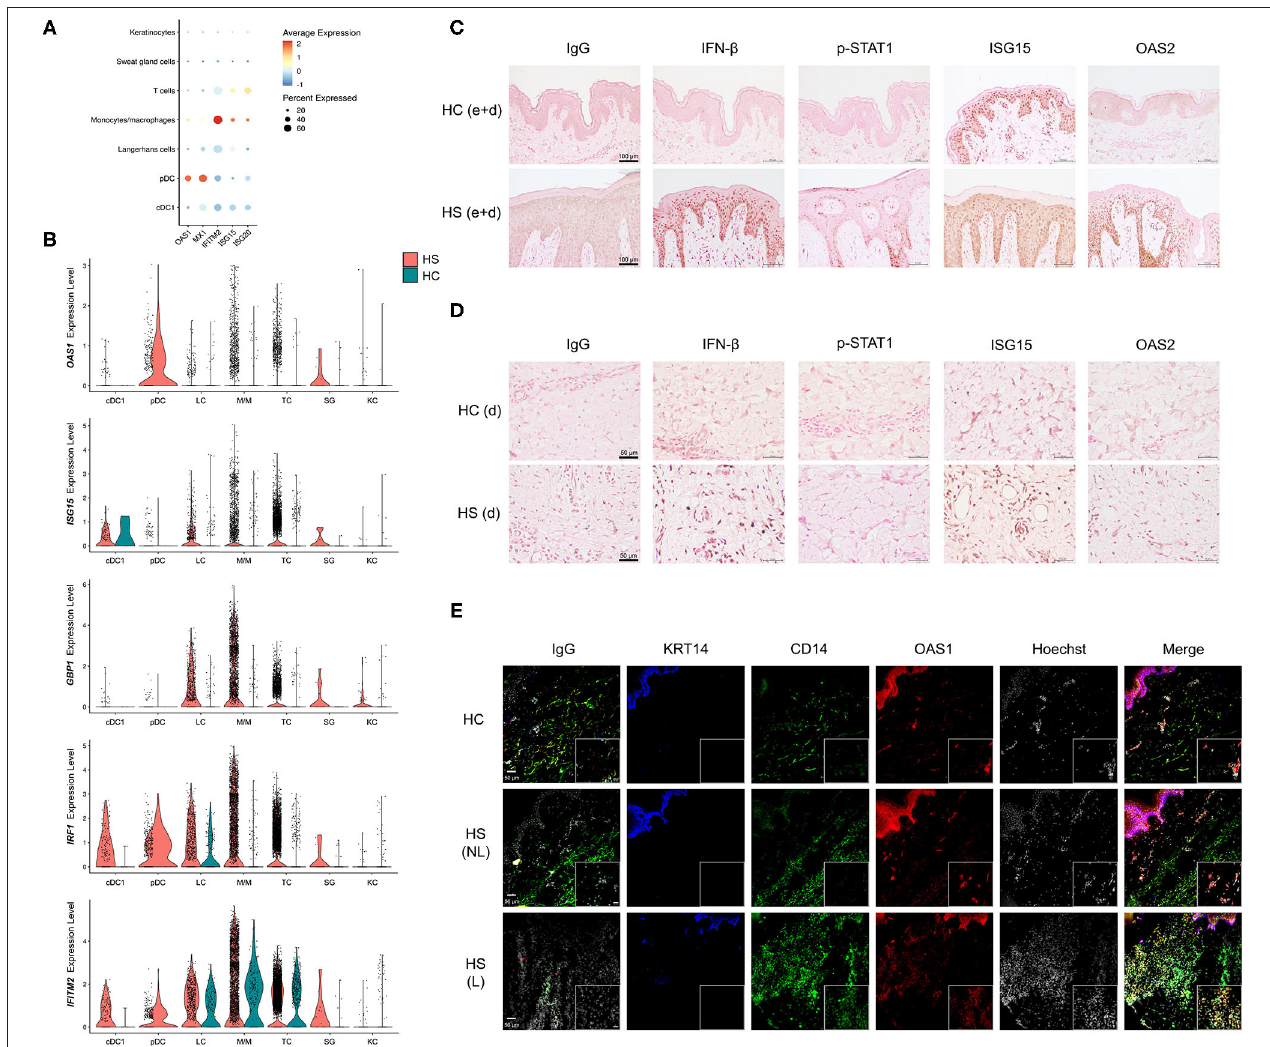
FIGURE 6 | Key cell populations have increased expression and production of antiviral proteins within HS skin lesions. (A) Dot plot showing the percent expressed and average expression of antiviral proteins between key cellular populations in HS skin. (B) Violin plots of antiviral protein expression within key cellular populations within HS and HC skin. (C,D) Immunohistochemical staining of IFN- β , phospho (p)-STAT1, ISG15, and OAS2 in HS and HC skin with focus on (C) epidermis and dermis (e + d) at 20X (scale bar 100 µ m) and (D) dermis (d) at 40X (scale bar 50 µ m). (E) Immunofluorescence colocalization staining of CD14 (green) and OAS1 (red) at 20X. Scale bar for the 20X image is 50 µ m, whereas, for the zoomed image is 20 µ m. KRT (keratin)-14 (blue) staining visualizes the epidermis. cDC, conventional dendritic cell; HC, healthy control; KC, keratinocyte; LC, Langerhans cell; M/M, monocyte/macrophage; pDC, plasmacytoid dendritic cell; SG, sweat gland cell; TC, T cell; NL, non-lesional; L,